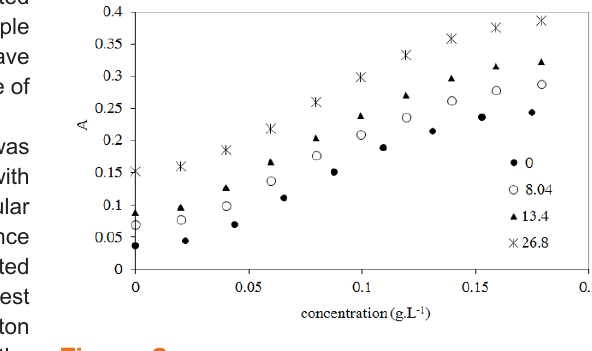
Figure 6. Calibration curves for Triton CF-21 for various concentrations of humic acid (mg L -1 Table 2. Test statistics F for all twins of the regression lines of both surfactants (each number is for curve in pure system compared with one A curve measured in the presence of humic acid); see Figs. 7 and 8. humic acid sodium salt concentration (mg L -1 )